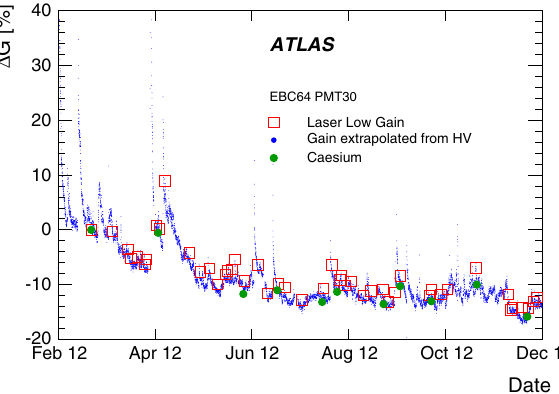
Fig. 19 One PMT of the EBC64 module with the largest gain varia- tion.Thisplotpresentsacomparisonbetweenthegainexpectedfromthe HV instability (tiny dots), the one measured by the laser (open squares) and Cs (full circles) systems during the whole 2012 run. One HV point represents the averaged gain variation over one hour. The vertical struc- tures are due to power cycles. There is very good agreement between the three methods, meaning that even large variations can be detected and handled by the TileCal monitoring and calibration